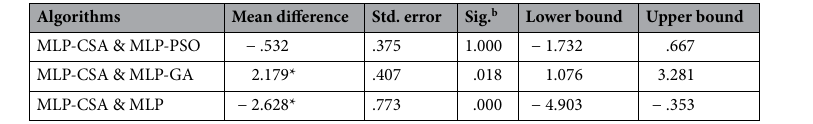
Table 7. Pairwise comparisons of all algorithms prediction error for the antimicrobial efficiency. *The mean difference is significant at the .05 level. b Adjustment for multiple comparisons: Bonferroni.